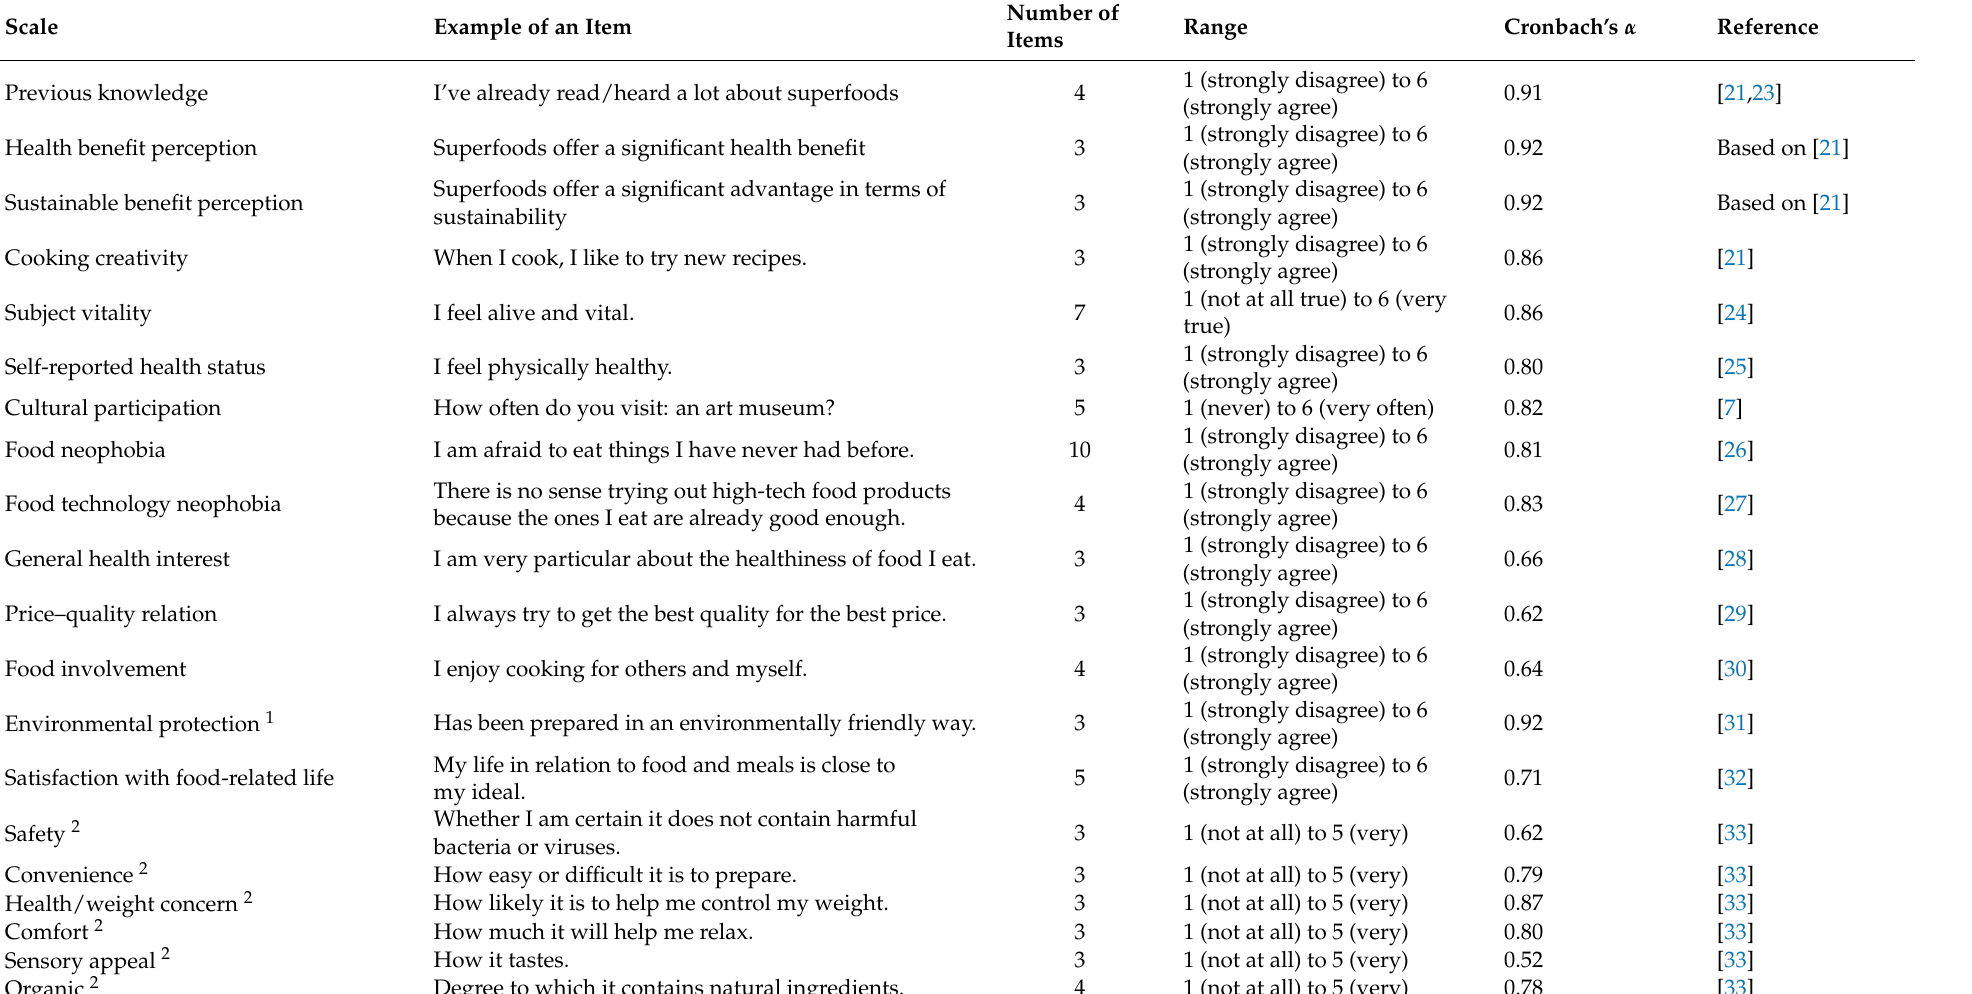
Table 2. Scales used in the questionnaire and their reliability